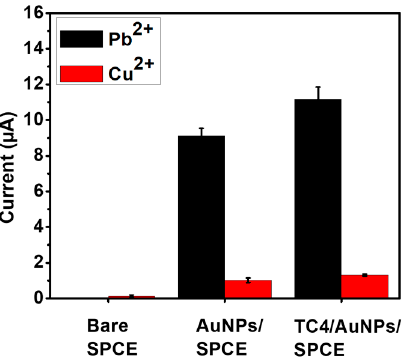
Figure 5. Comparison of 1.0 ppm Pb 2+ and Cu 2+ detection using bare SPCE, AuNPs/SPCE, and TC4/AuNPs/SPCE in 0.1 M, pH 8 KCl at optimum conditions of 120 s deposition time and a depo- sition potential of − 1.2 V (Pb 2+ ) and − 1.1 V (Cu 2+ ).